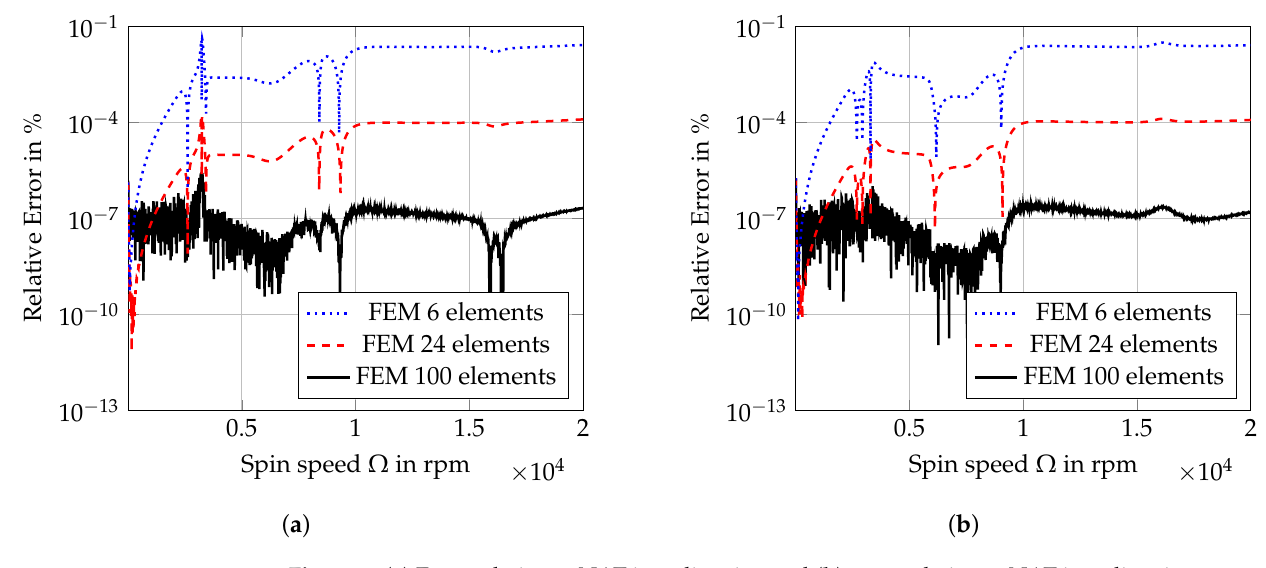
Figure 7. ( a ) Error relative to NAT in x -direction and ( b ) error relative to NAT in y -direction. Table 4. Average relative error in %.